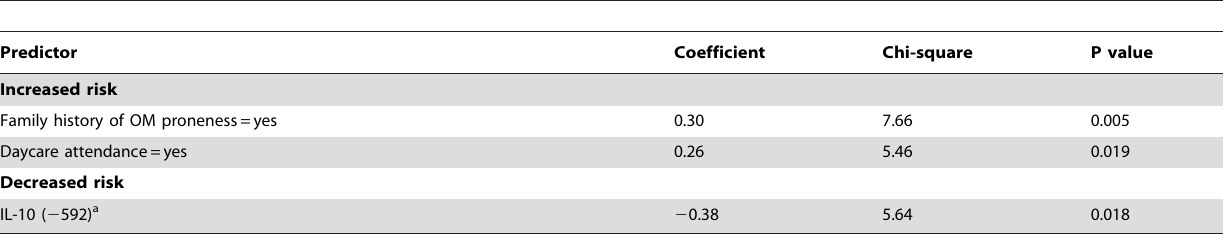
Table 5. Poisson multiple regression model ( R 2 =0.16) to predict the number of acute OM occurrences during URI episodes in 202 children of the prospective study